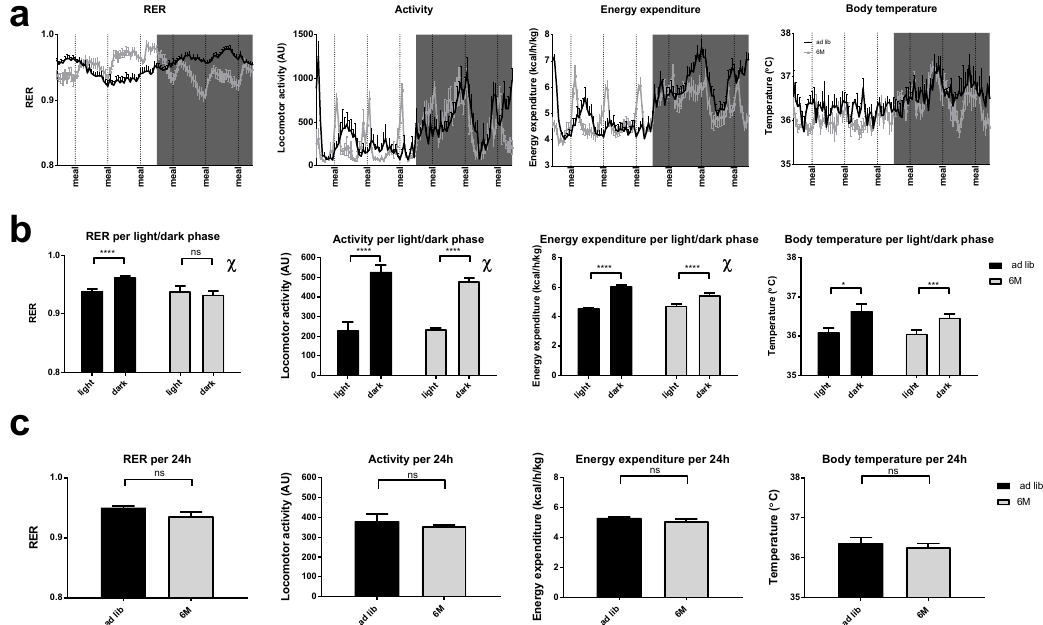
Figure 2. Analysis of the metabolic parameters RER, locomotor activity, heat production and subcutaneous body temperature (from left to right, respectively) of the animals in the metabolic cages. While in the metabolic cages, animals remained on their assigned feeding regimen. ( a ) 24 h traces of the metabolic parameters, averaged per group. The timing of the meals for the 6M group are indicated along the x-axis. ( b ) Difference within metabolic parameters between light and dark phase for the ad libitum and 6M fed animals, i.e., asterisks and ns refer to light/dark differences within the ad libitum and 6M group. ( c ) Average 24 h values of the metabolic parameters for both groups of animals. Data are depicted as means ± SEM. χ = indicates that a significant interaction was found for Feeding × L/D, ns = non-significant, **** p < 0.0001, *** p < 0.001, * p < 0.05, n = 15–16 per group, except for subcutaneous body temperature ( n = 3–5 per group). Locomotor activity is presented as arbitrary units (AU). ad lib = ad libitum fed animals (black lines and bars), 6M = animals fed according to the 6-meals-a-day feeding regimen (grey lines and bars). Shaded areas represent the dark